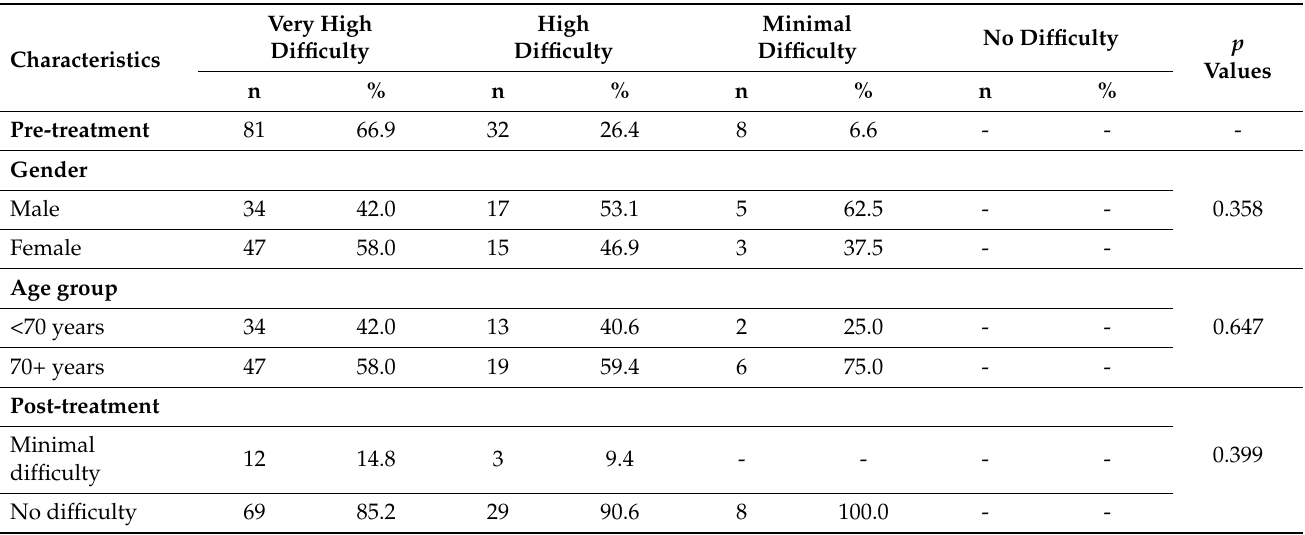
Table 6. The percentage distribution of patients with visual difficulties during manual work according to pre- and post-treatment study group